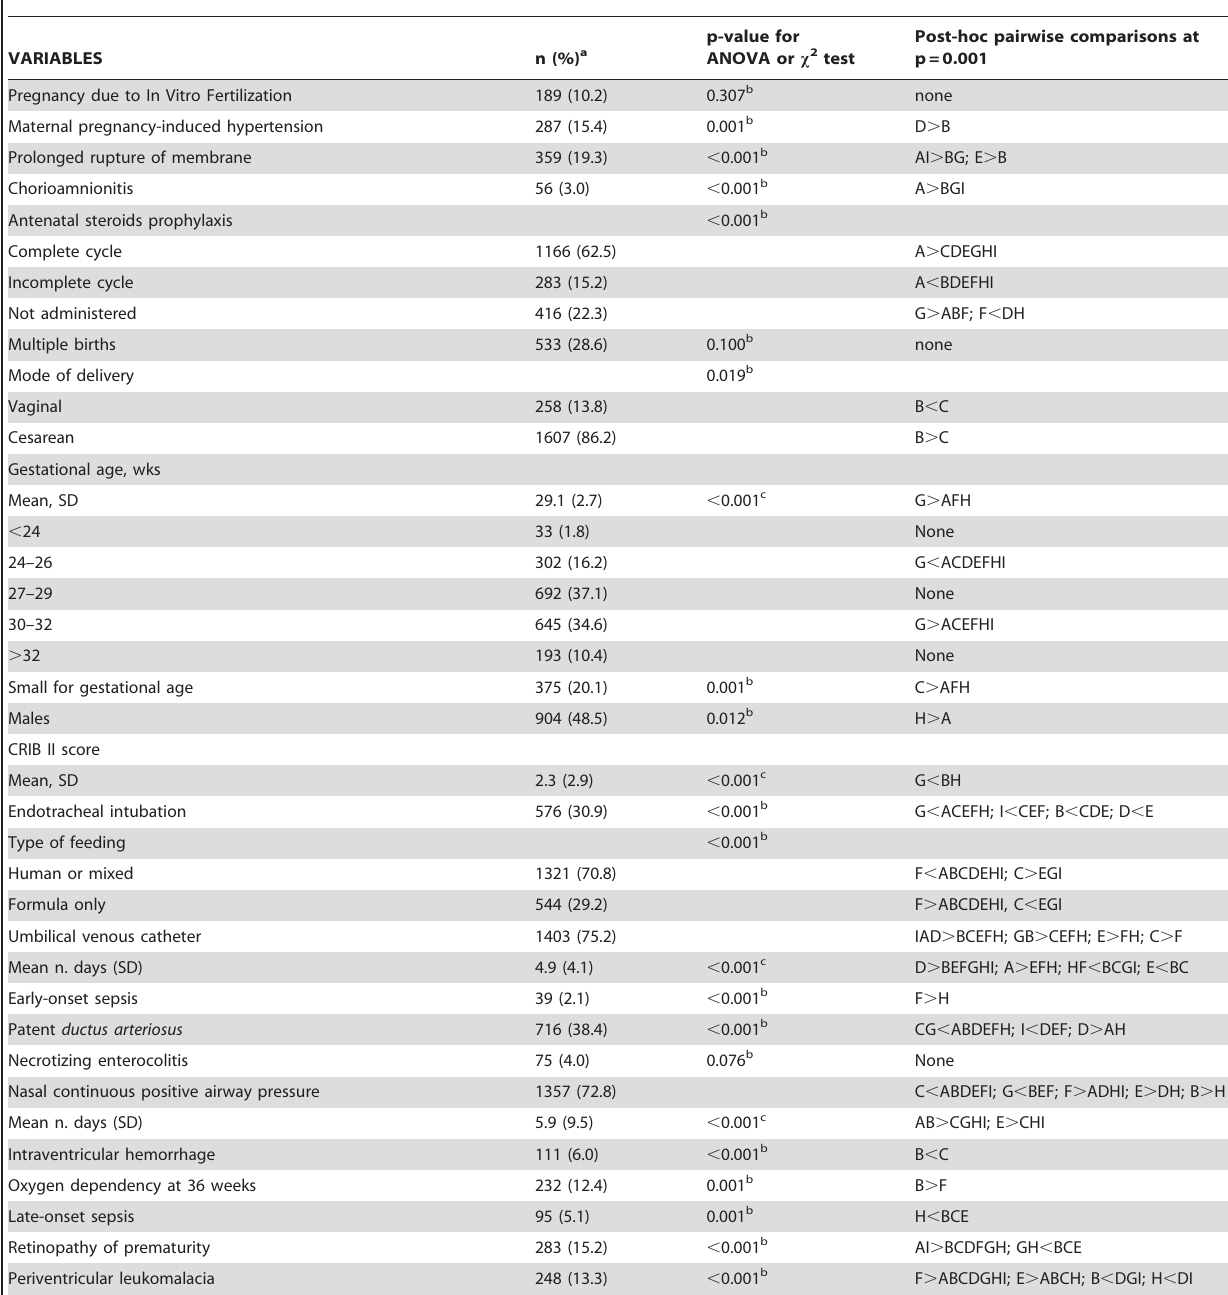
Table 1. Clinical characteristics of the very low birth weight infants included in the study cohort (n=1864).